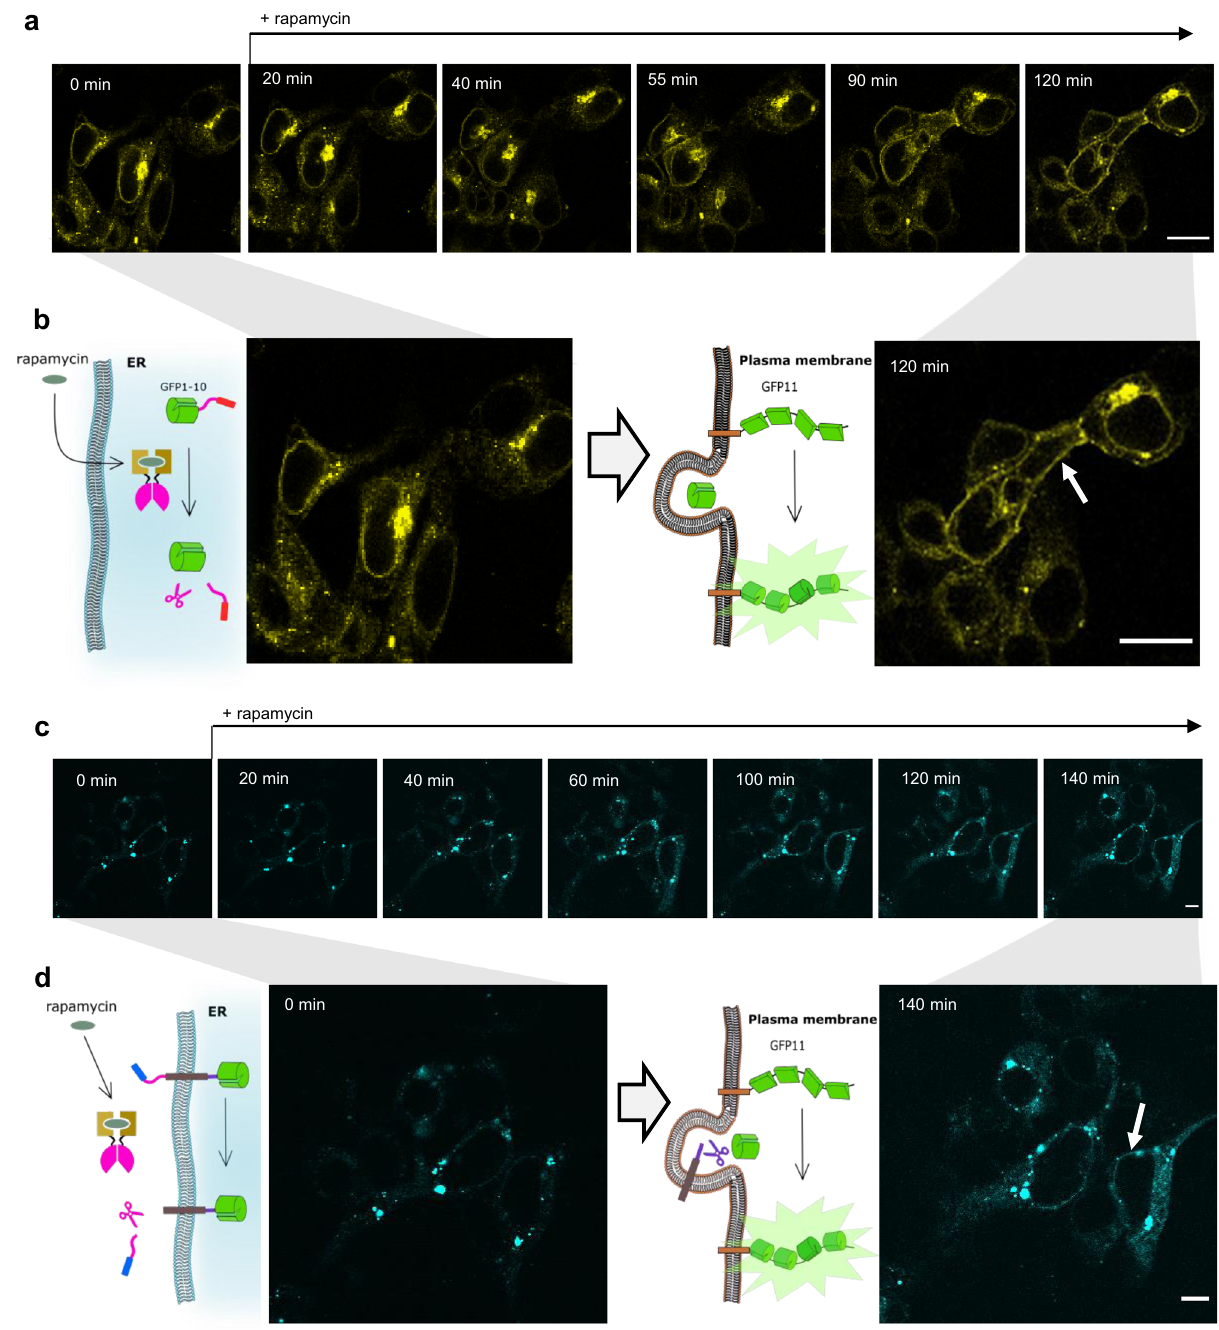
Fig. 3 Single cell visualization of protein traf fi cking in the lumER and membER system. a GFP signal was visualized on the same group of cells over a period of 2 h. b Close up of cells before the addition of rapamycin and of 2 h after the addition of rapamycin. The signal begins to appear at the plasma membrane (white arrow) after ~60 min. c GFP signal was visualized on the same group of cells over a period of 140 min. The signal begins to appear at the plasma membrane (white arrow) after ~110 min. d Close up of cells before the addition of rapamycin and 140 min after the addition of rapamycin with an arrow indicating localization at plasma membrane. Scale bar = 10 µ m. Images are representative of three independent experiments. Source data are provided as a Source Data fi